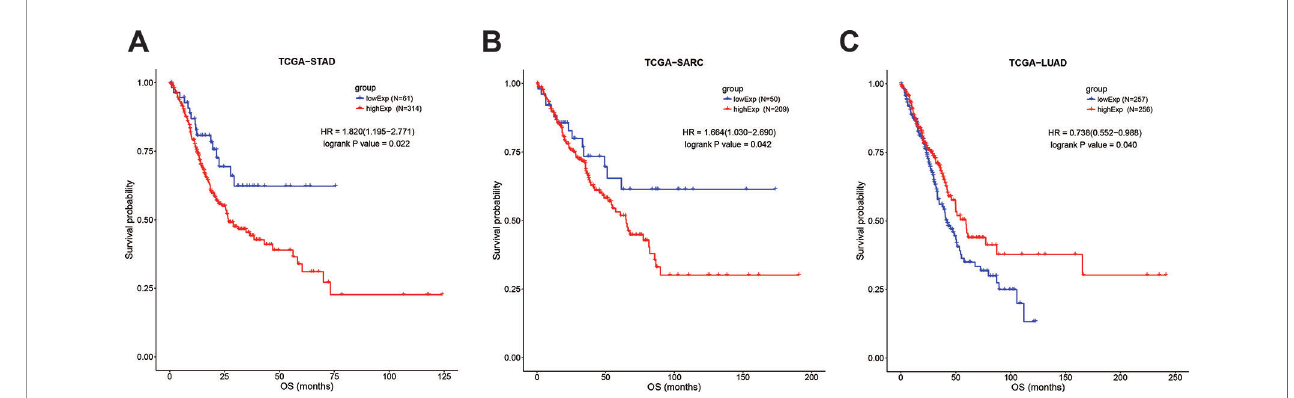
FIGURE 6 | Kaplan-Meier survival curves for the overall survival of cancer patients, strati fi ed by SOX2-OT expression levels. (A) TCGA-STAD, (B) TCGA − SARC, (C) TCGA − LUAD. STAD, gastric cancer; SARC, sarcoma; LUAD, lung adenocarcinoma.